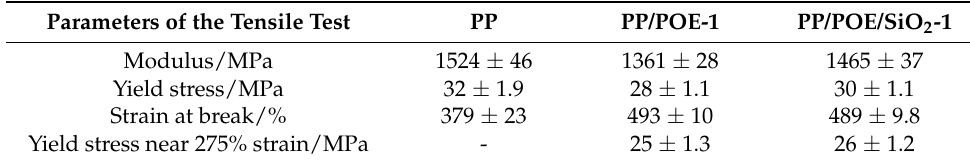
Table 4. Parameters of the tensile